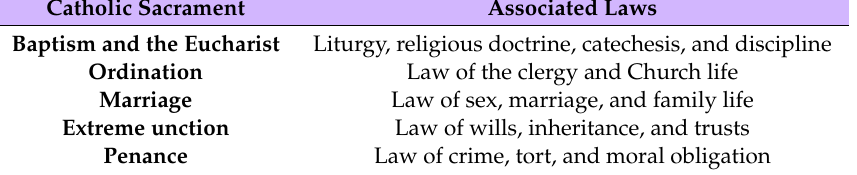
Table 4. Examples of medieval canon laws supported by Roman Catholic sacraments (Witte 2002, pp.